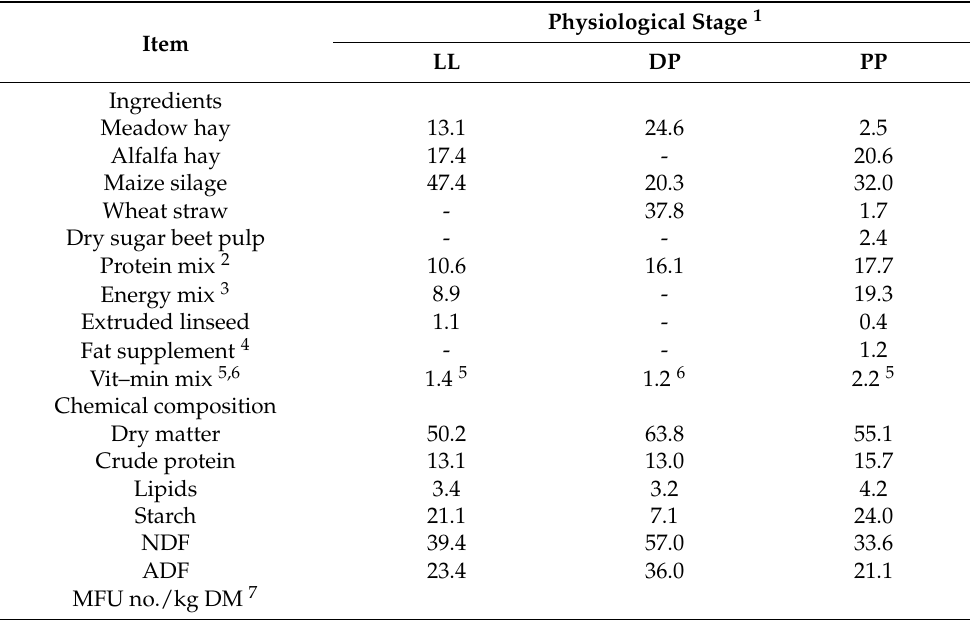
Table 1. Ingredients (% of dry matter) and composition (% of dry matter) of the total mixed rations (TMR) fed to the cows during three different physiological stages. Physiological Stage 1 Item LL DP PP Ingredients Meadow